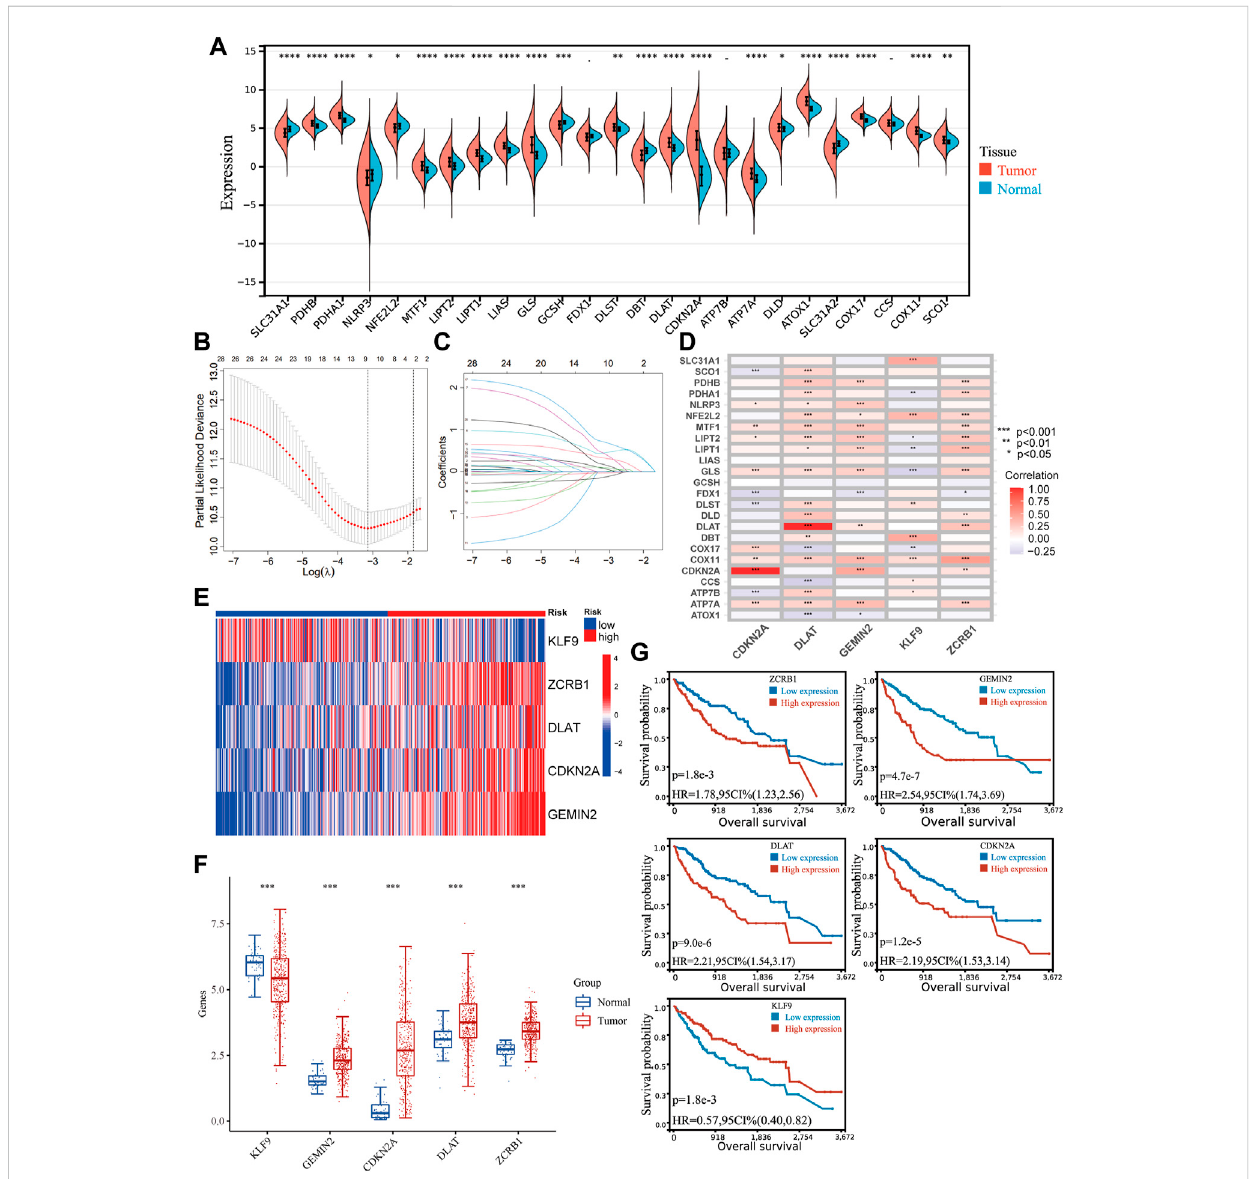
FIGURE 1 Identifying genes related to copper homeostasis and cuproptosis and development of the signature. (A) Expression of 25 genes in HCC and normal tissues. Unpaired Wilcoxon Rank Sum and Signed Rank Test was applied for difference signi fi cance analysis. (B) Ten-fold cross-validation of the LASSO Cox regression model ’ s tuning parameter ( λ ) selection. Based on the minimum criteria and the 1-SE criteria, vertical lines were drawn at the optimal values. (C) LASSO coef fi cient pro fi les of the prognostic genes. (D) The correlation between the fi ve genes in the signature and the genes directly participating in copper homeostasis and cuproptosis. (E) The expression of the fi ve hub genes in the TCGA cohort. (F) Differential expression of the hub genes between HCC and normal tissues. (G) Kaplan − Meier plots of CDKN2A, KLF9, DLAT, GEMIN2, and